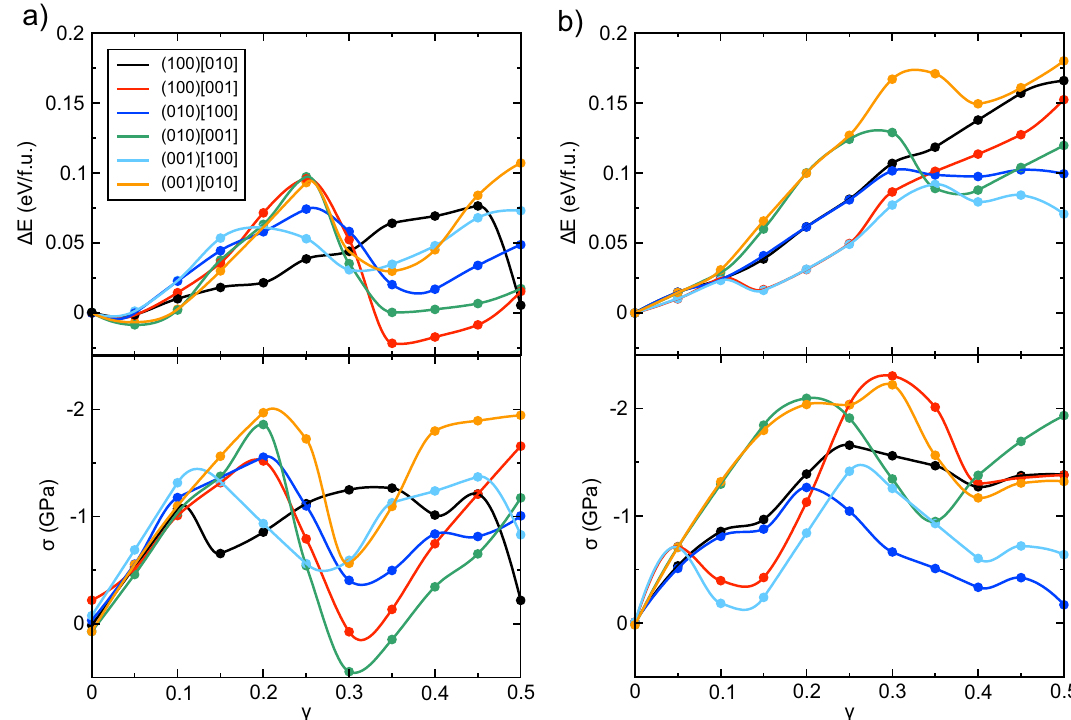
Figure 5. Average potential energy and shear stress. Changes of the average potential energy Δ E (upper panel) and average shear stress σ (lower panel) of ( a ) Ag 2 S and ( b ) Ag 2 Se as a function of shear deformation γ . The black, red, blue, green, cyan, and orange correspond to the (100)[010], (100)[001], (010)[100], (010)[001], (001) [100], and (001)[010] shear system, respectively. The average value was calculated using latest 500 MD step (= 0.5 ps) for each γ . The data points are interpolated using Akima spline